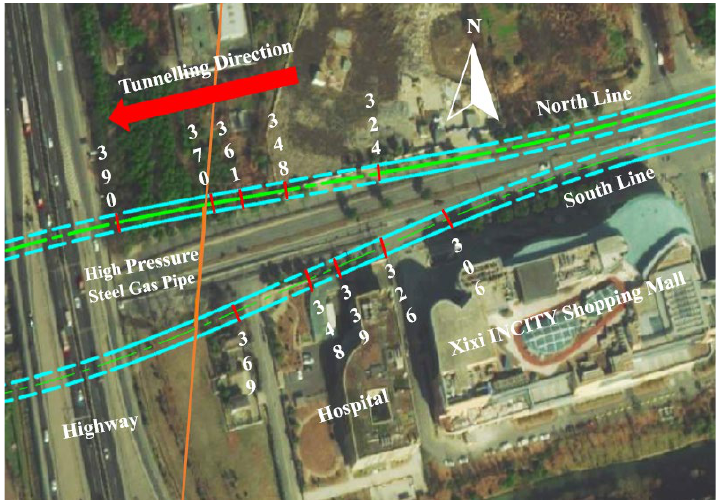
Figure 1. Project Overview.